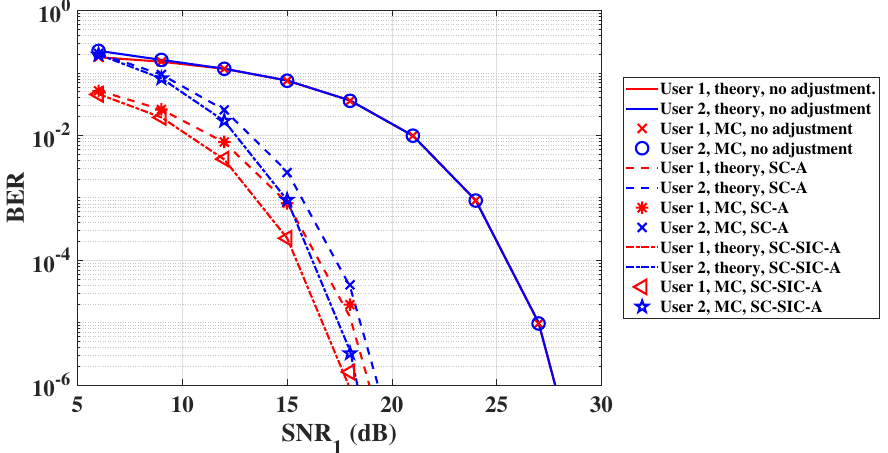
Figure 3. The SCs of ( a ) the no adjustment scheme, ( b ) the SC-A scheme and ( c ) the SC-SIC-A scheme. The parameters of ( b , c ) are obtained, when K = 2 and γ 1 = 21 dB. Colours and markers are used to distinguish the data of user 1.